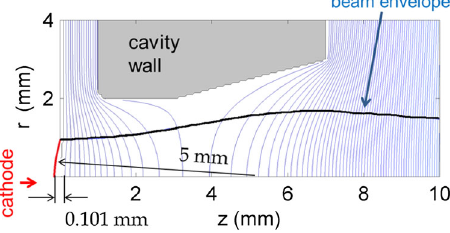
FIG. 16. Gun geometry with the optimized cathode profile.